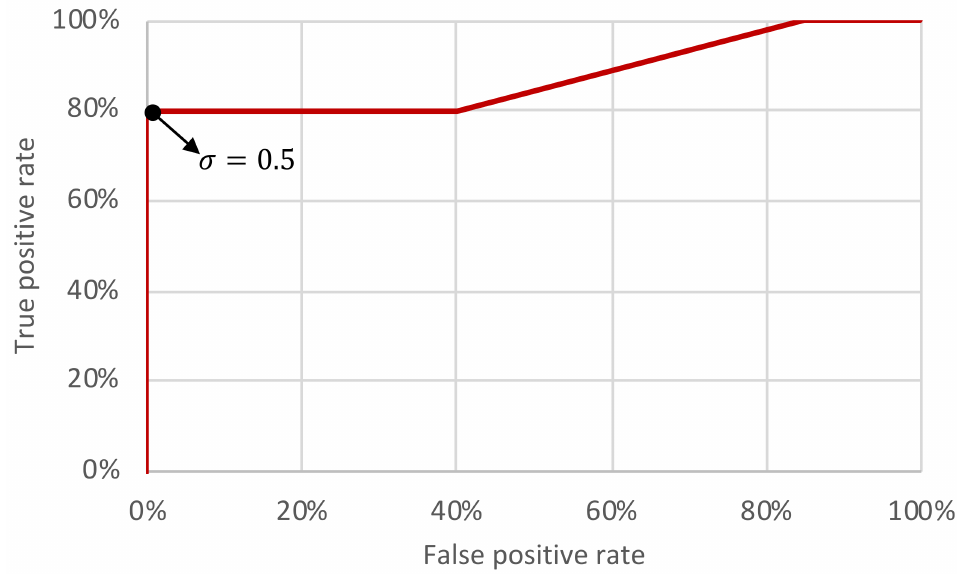
Figure 15. ROC curve of the triggering mechanism in an AIS/ECDIS